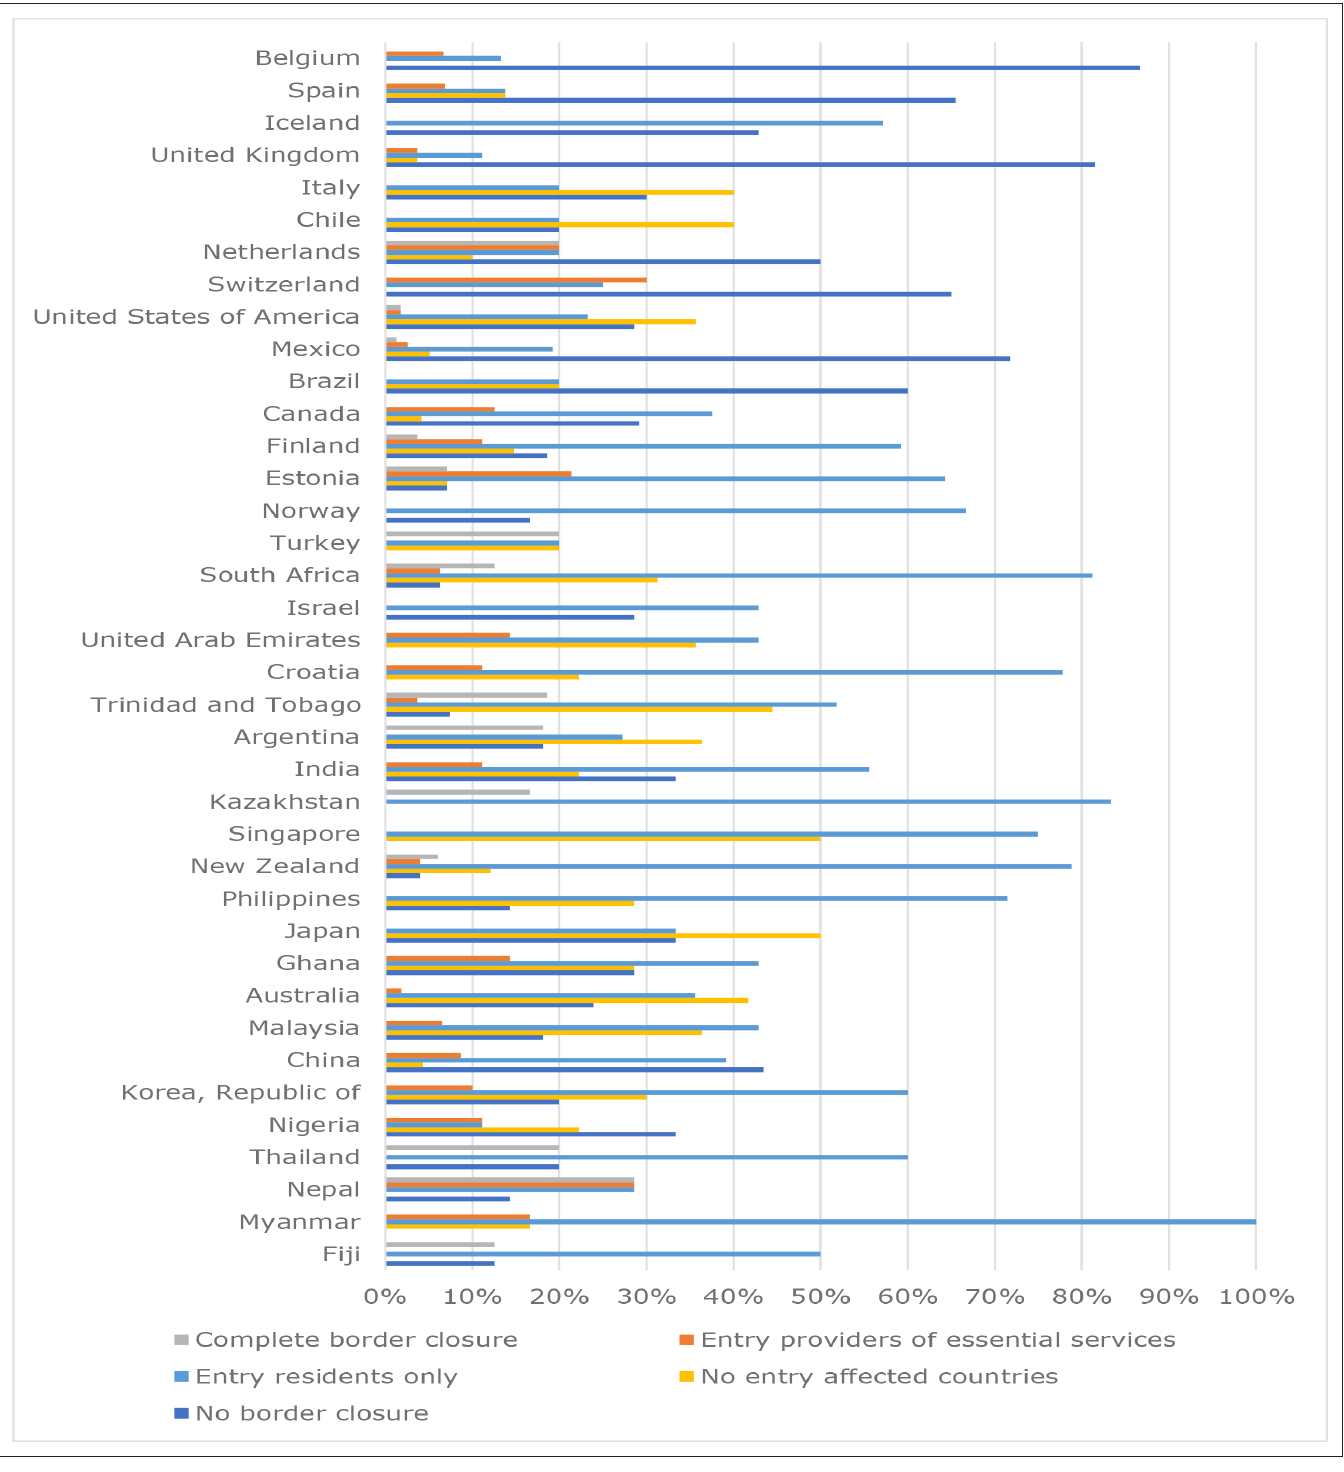
Figure 4 Responses on border closure at time of first mortality for 38 countries from highest (Belgium) to lowest (Fiji) mortality